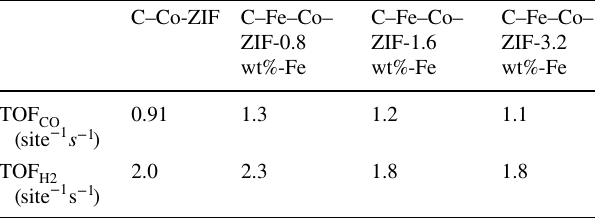
Table 1 TOF of the catalysts at -0.7 V versus RHE